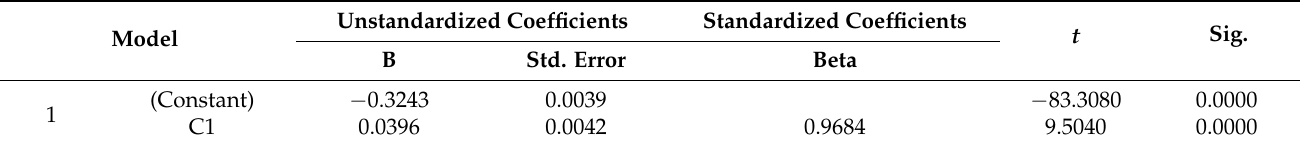
Table 14. Coefficients of